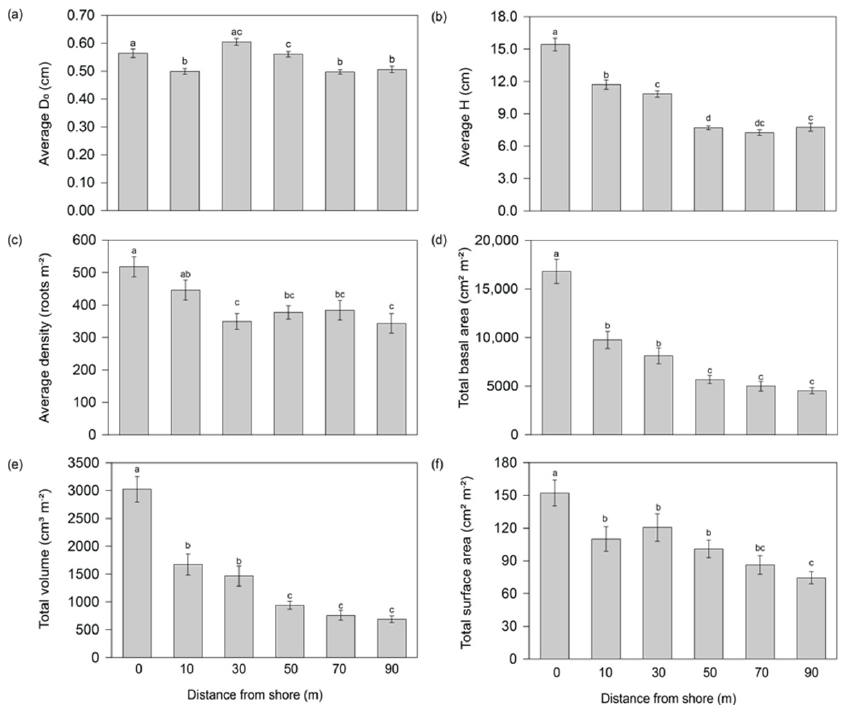
Figure 5. Quantitative characteristics of pneumatophores (mean ± SE) along the transects, including diameter at ground level ( a ), height ( b ), density ( c ), total basal area ( d ), total volume ( e ), and total surface area ( f ). Different letters indicate significant differences based on a post hoc test (pairwise comparison) at p < 0.05.